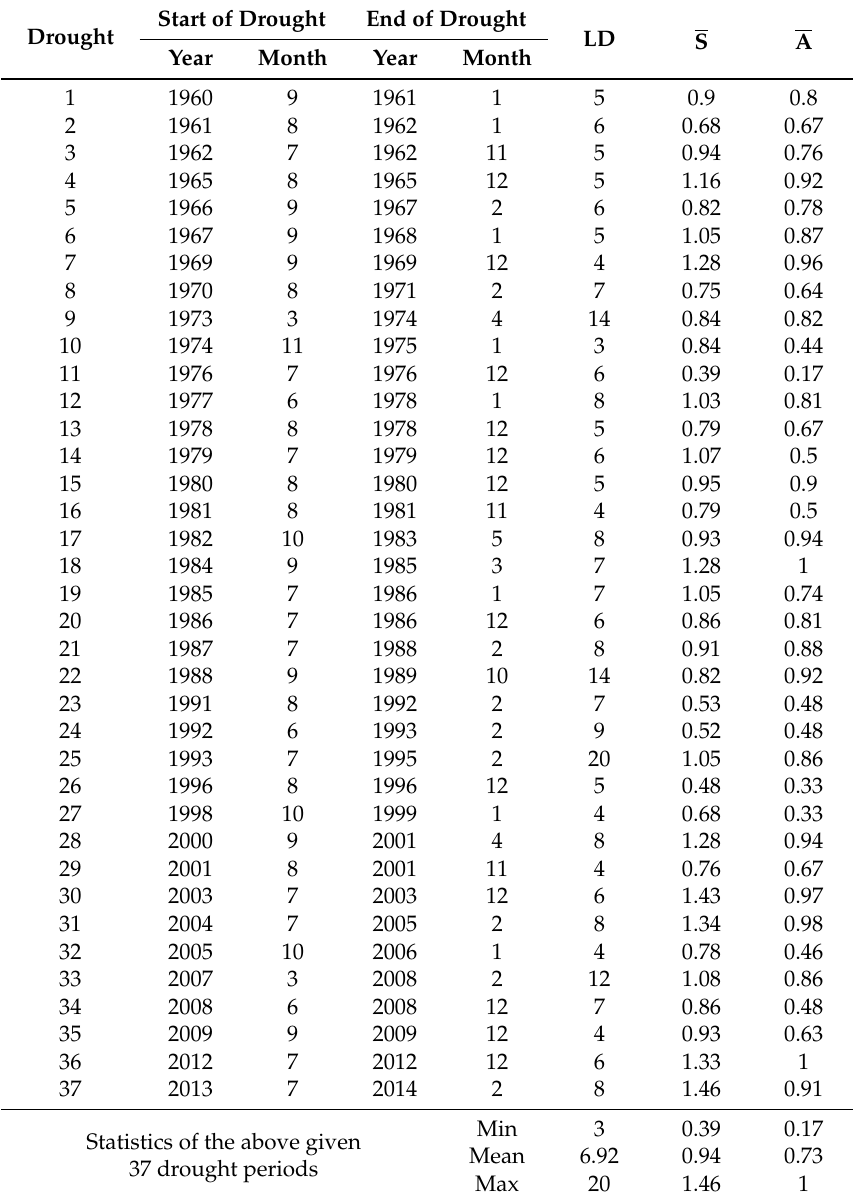
Table 3. Drought characteristics defied by using SPI series